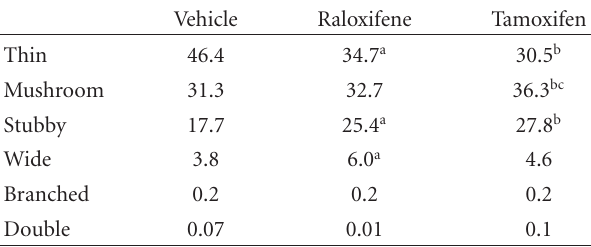
Data represent means from 6 animals in each experimental group. a–c Significant di ff erences, P < 0 . 05; a raloxifene versus Vehicle; b tamoxifen versus Vehicle; c tamoxifen versus